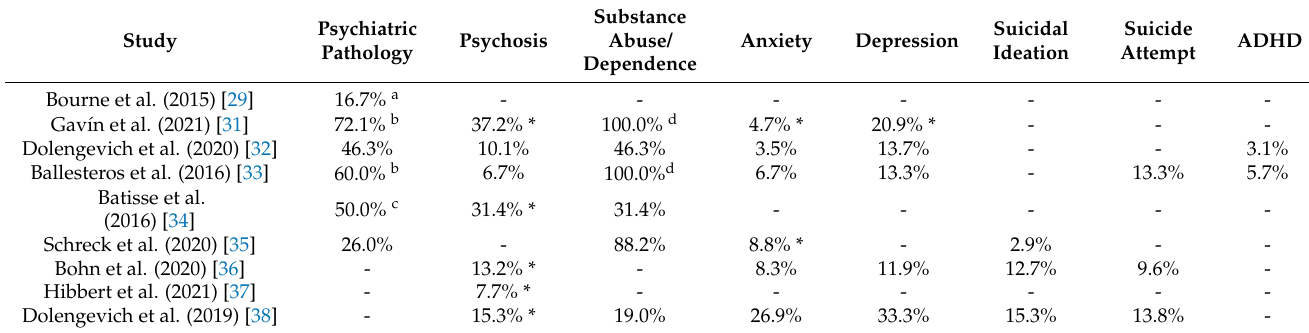
Table 4. Psychiatric symptomatology/disorders over population sample